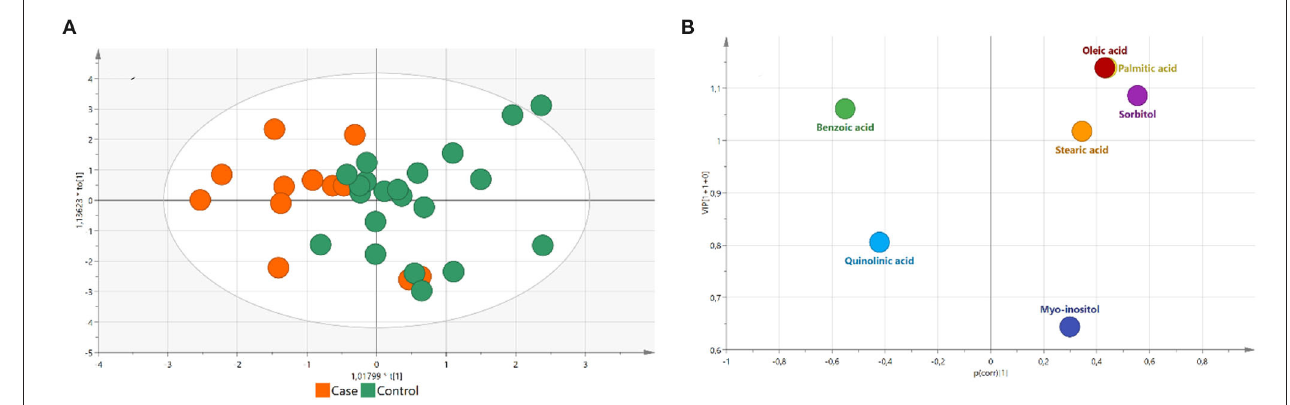
FIGURE 2 | (A) Orthogonal partial least square-discriminant analysis (OPLS-DA) plot for significantly different compounds between PD cases and control subjects (R2X = 0.563, R2Y = 0.402, and Q2 = 0.165). Cases are marked as orange and controls are marked as green; (B) Volcano plot plotting VIP in OPLS-DA model against p[corr] value for significantly different compounds between PD cases and control subjects. Colored according to identifiers.